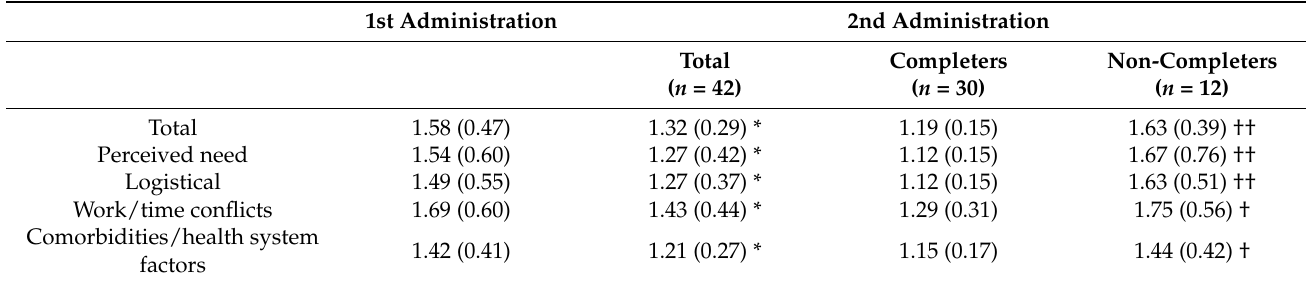
Table 5. Differences in total and subscale CR barrier scores between 1st and 2nd administration of the CRBS-CZE, and by CR completion ( n =